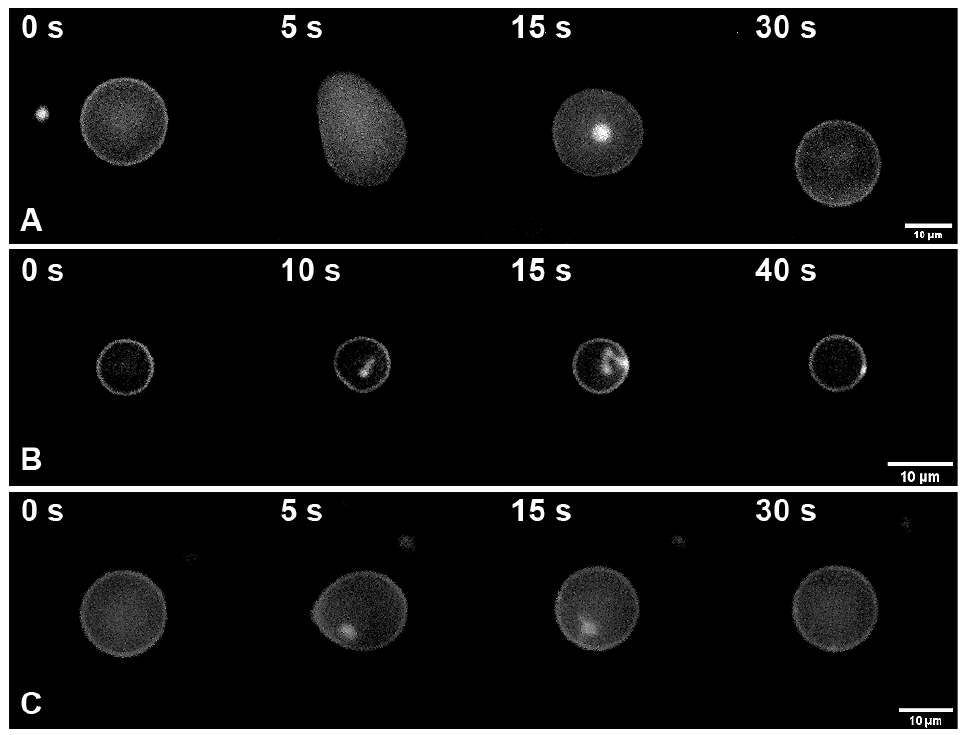
Figure 3. Time course of the GUV reaction on the transient hyperosmotic stress. ( A ) — GUV formed from DOPC; ( B ) — GUV formed from 70 mol.% DOPC + 30 mol.% Ergosterol; ( C ) — GUV formed from 70 mol.% DOPC + 30 mol.% Cholesterol. Time in seconds passed from the application of the hyperosmotic stress is indicated in left upper corners. Time count starts from the moment of the application of the hyperosmotic solution. Scale bar is 10 μ m. Table 2. Reduction of the average diameter of GUVs depending on the time from the start of hyperosmotic stress. Errors are standard deviations of the corresponding values. 15 s from the Start of 30 s from the Start of GUV Composition Application of the Application of the Hyperosmotic Solution Hyperosmotic Solution DOPC 12 ± 5% 3 ± 2% 70 mol.% DOPC + 5 ± 3% 2 ± 1% 30 mol./% Ergosterol 70 mol.% DOPC + 4 ± 2% 3 ± 30 mol./% Cholesterol